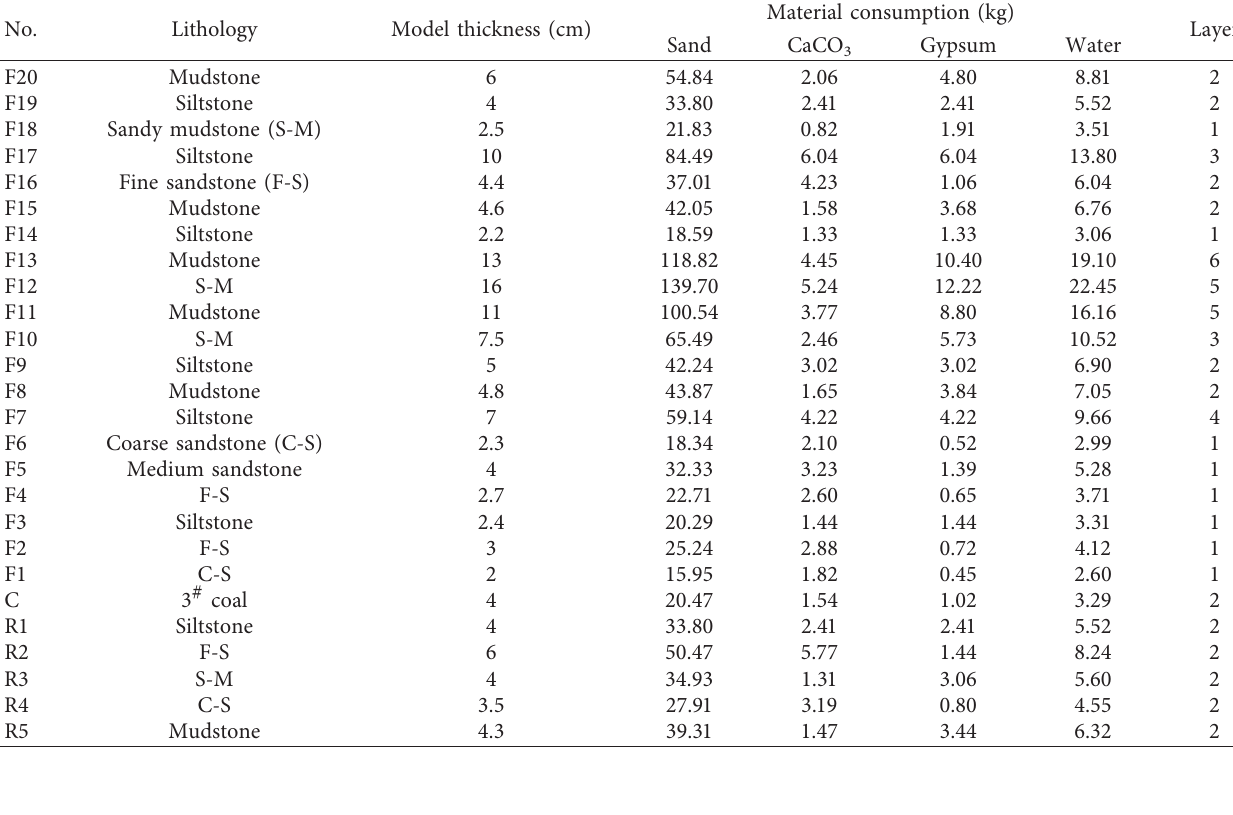
Table 1: Ratio of laying materials.